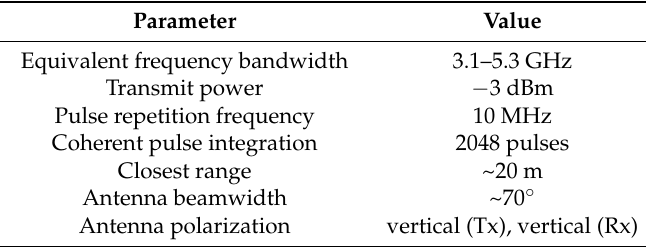
Table 2. Drone imaging measurement